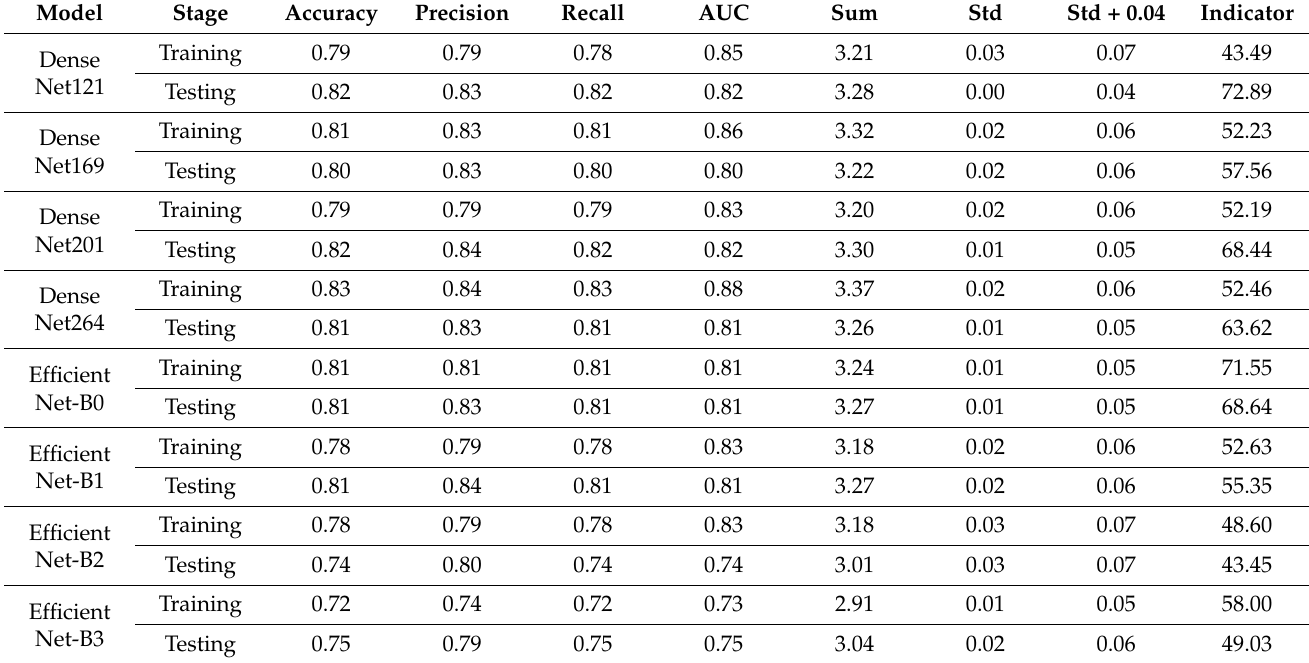
Table 13. The acquired comprehensive indicators of all DL model performance indices for AD vs.